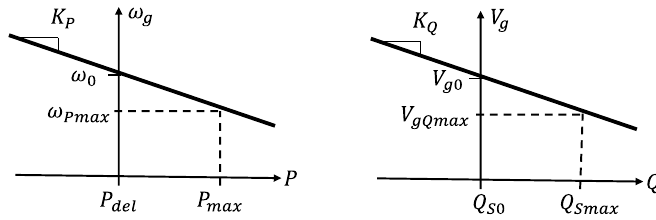
Figure 6. Droop characteristics. Left frequency, right voltage.